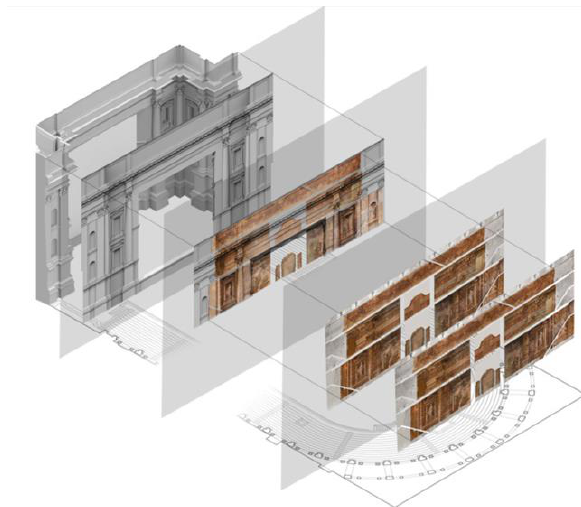
Figure 10 . Projection of the 3D model of the proscenium and the mesh model of the fresco on the same reference